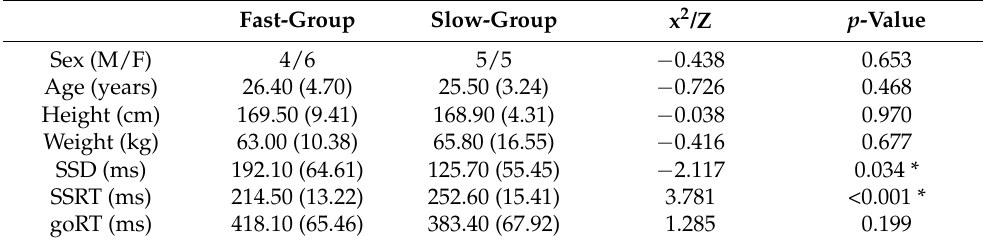
Table 1. General characteristics and comparison of stop-signal task parameters between the groups. Fast-Group Slow-Group x 2